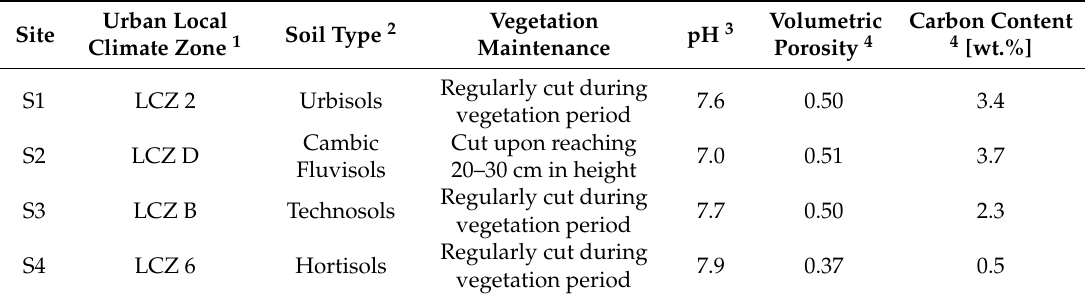
Figure 2. CO 2 flux measurement locations in Krakow: soil chamber sites S1–S4 marked in green, riverine sites R1–R3 marked in blue, and relaxed eddy accumulation(REA-AGH) site marked in red. Arrow indicates river flow direction; black triangles indicate inflows of treated municipal wastewater effluents to the river (map source: Google Maps; modified). Table 1. Characteristics of soil CO 2 flux measurement sites.